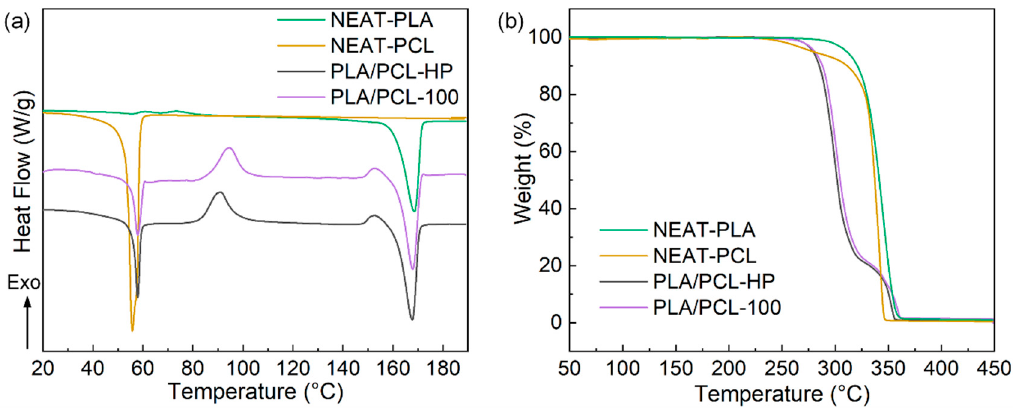
Figure 3. ( a ) DSC, ( b ) TGA curves of NEAT-PCL, NEAT-PLA, PLA/PCL-HP and PLA/PLC-100 sam- ples.